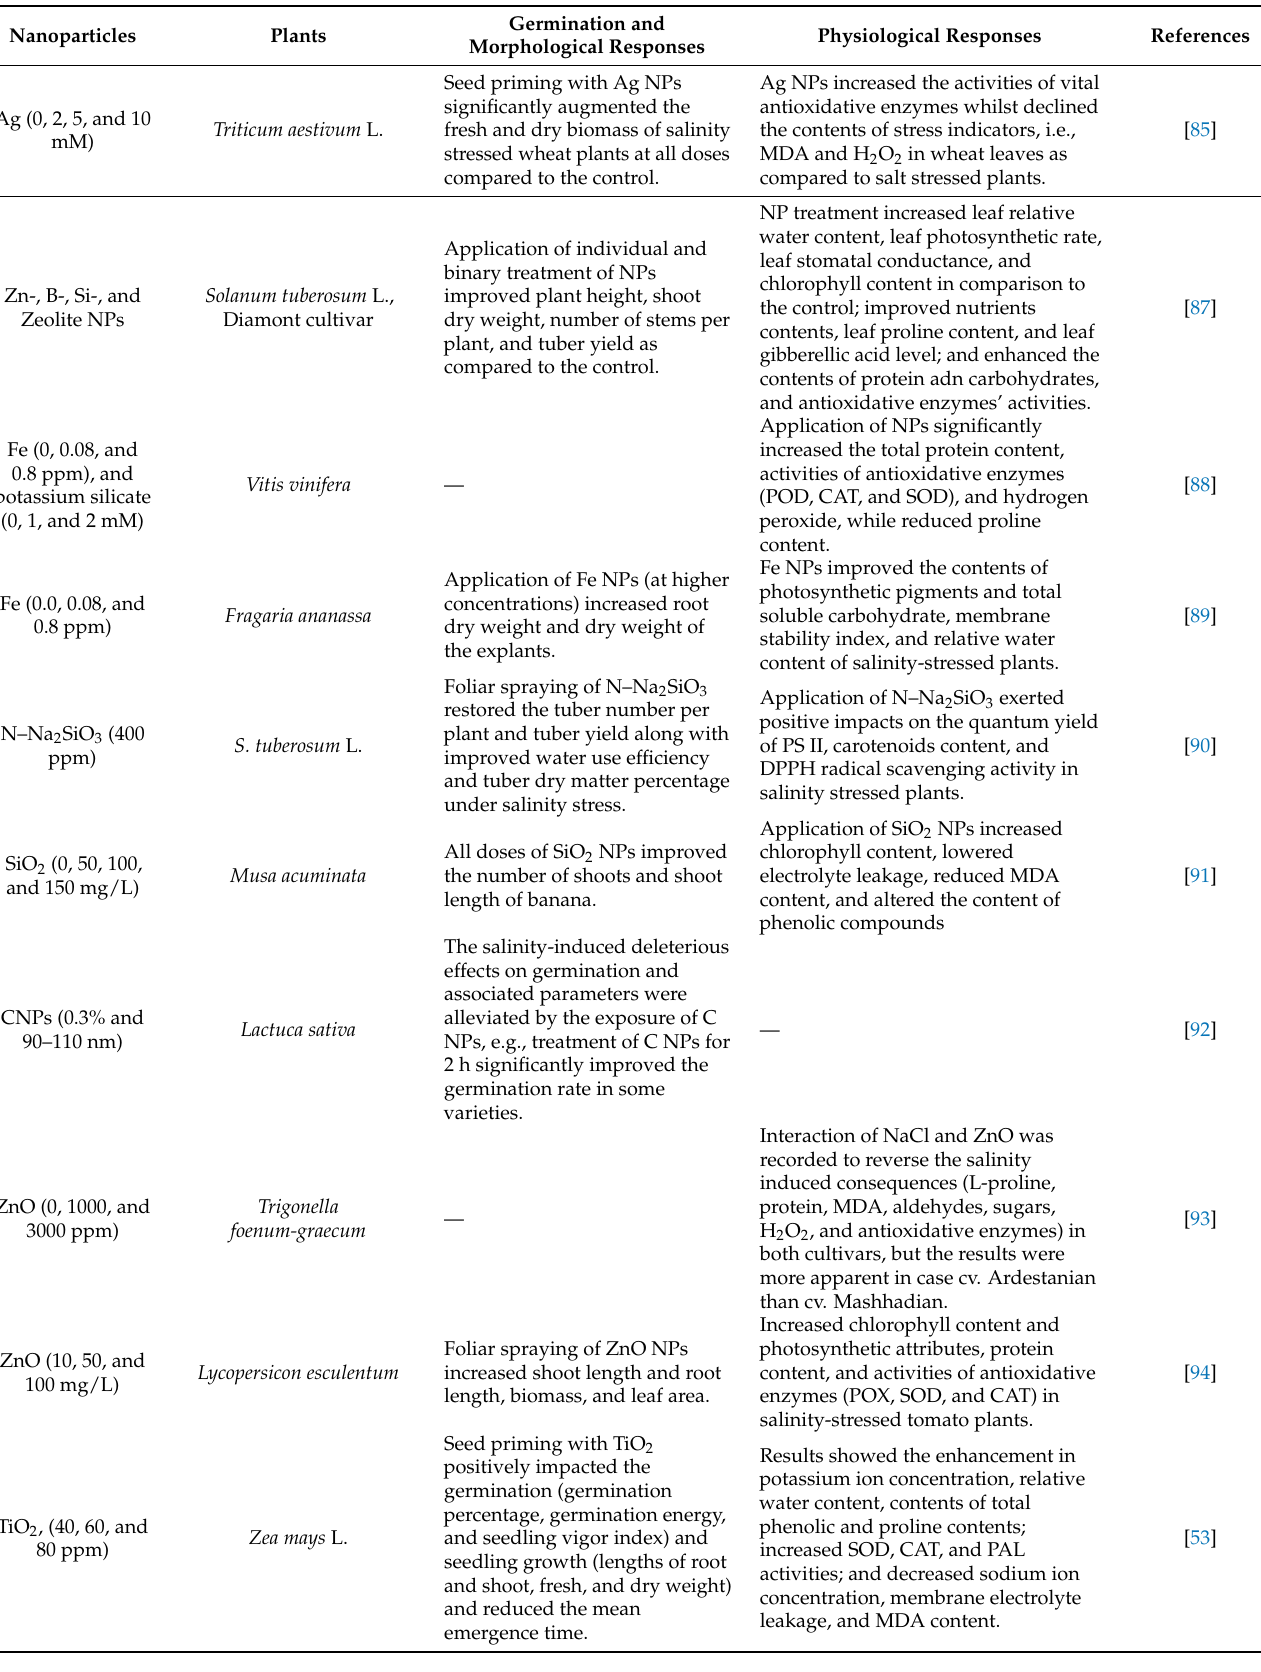
Table 2. Applications of NPs in salinity stress mitigation by altering the morphophysiological responses of plants.